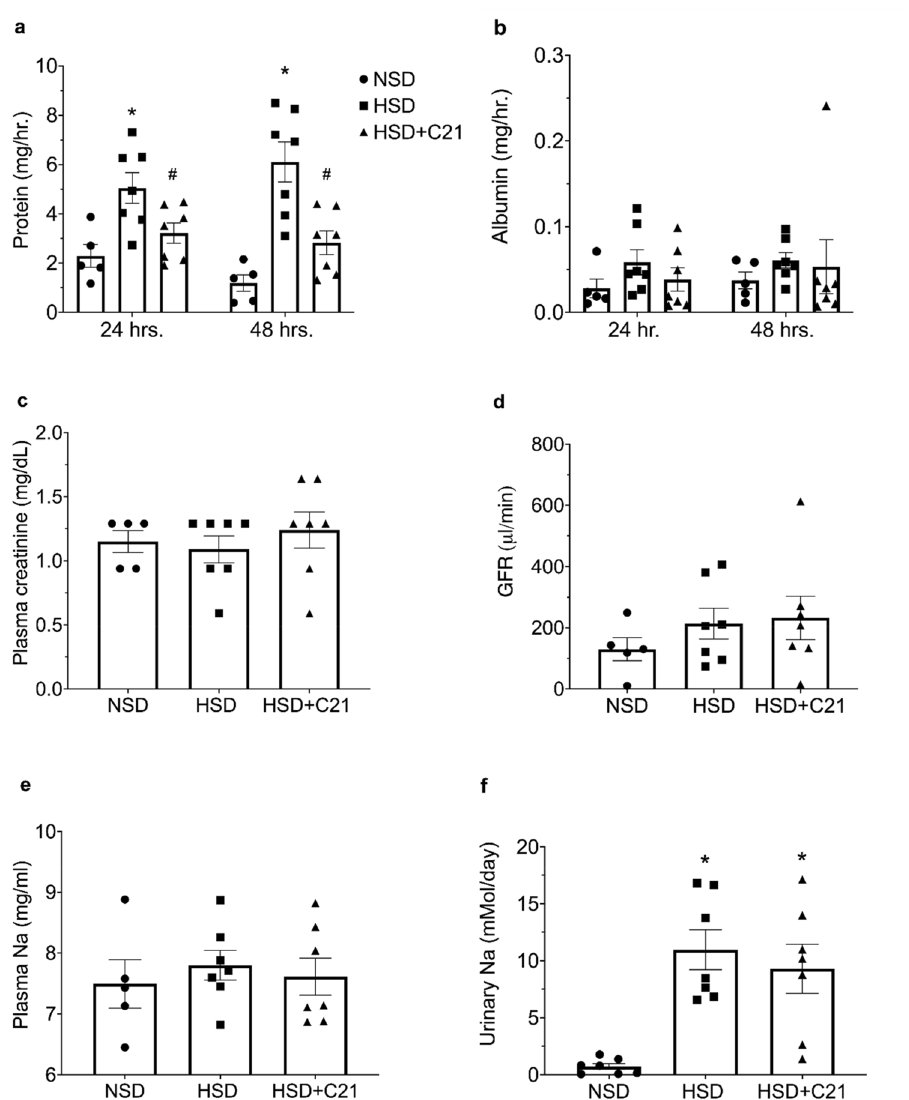
Figure 1. Effect of C21 treatment on renal function parameters of OZR fed with HSD or HSD + C21 for 48 h. Total urinary protein (proteinuria; a ), total urinary albumin (albuminuria; b ), plasma creatinine ( c ) and GFR ( d ). HSD and HSD + C21 treatment had no effect on plasma sodium concentration ( e ) however, HSD and HSD + C21 treatment groups exhibited a significant amount of sodium excretion in the urine as compared to NSD group ( f ). The values are represented as mean + sem; two-way ANOVA and one-way ANOVA followed by Fisher’s LSD test. * p < 0.05 versus NSD and # p < 0.05 versus